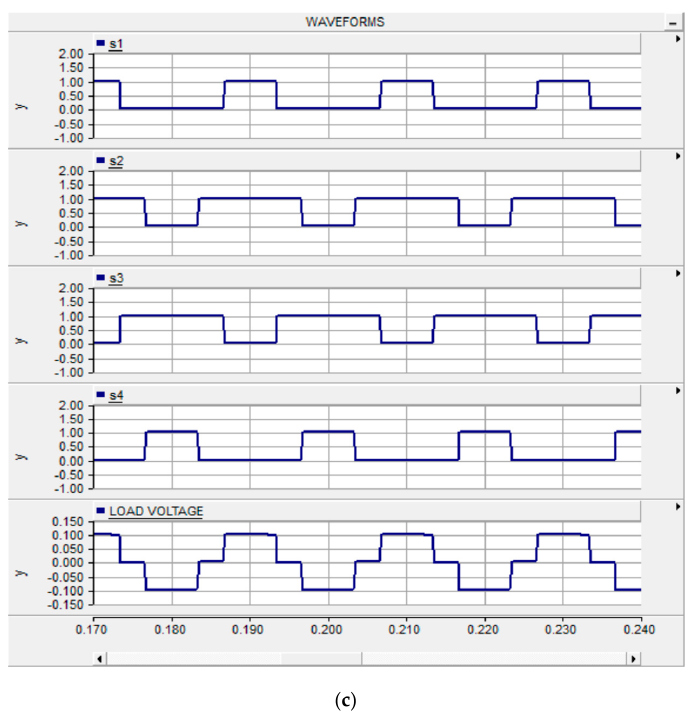
Figure 4. ( a ) Power circuit of 3- level DC-MLI; ( b ) control circuit of 3- level DC-MLI; ( c ) phase output voltage waveform of 3-level DC-MLI. Table 1. 3- Voltage levels of DC-MLI and switching states.